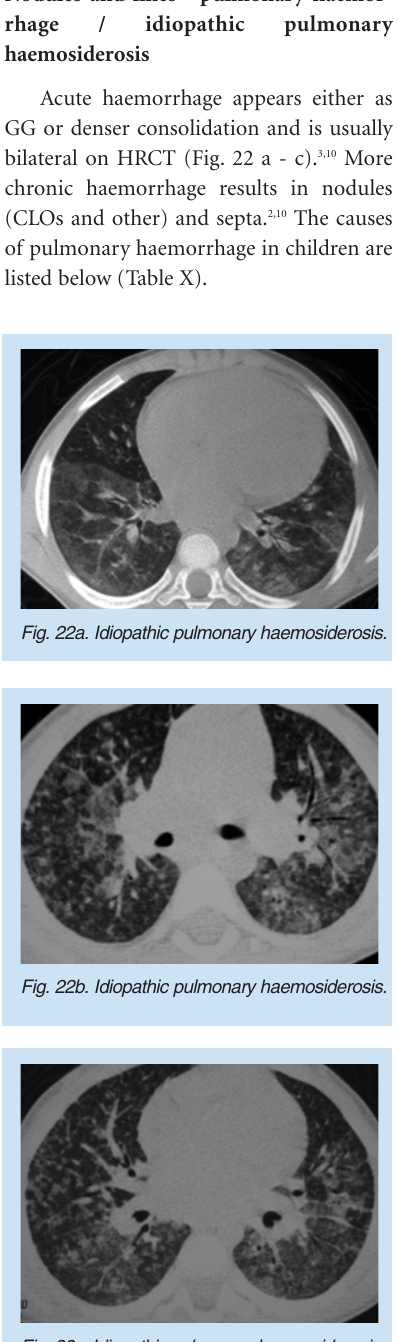
Fig. 22c. Idiopathic pulmonary haemosiderosis.